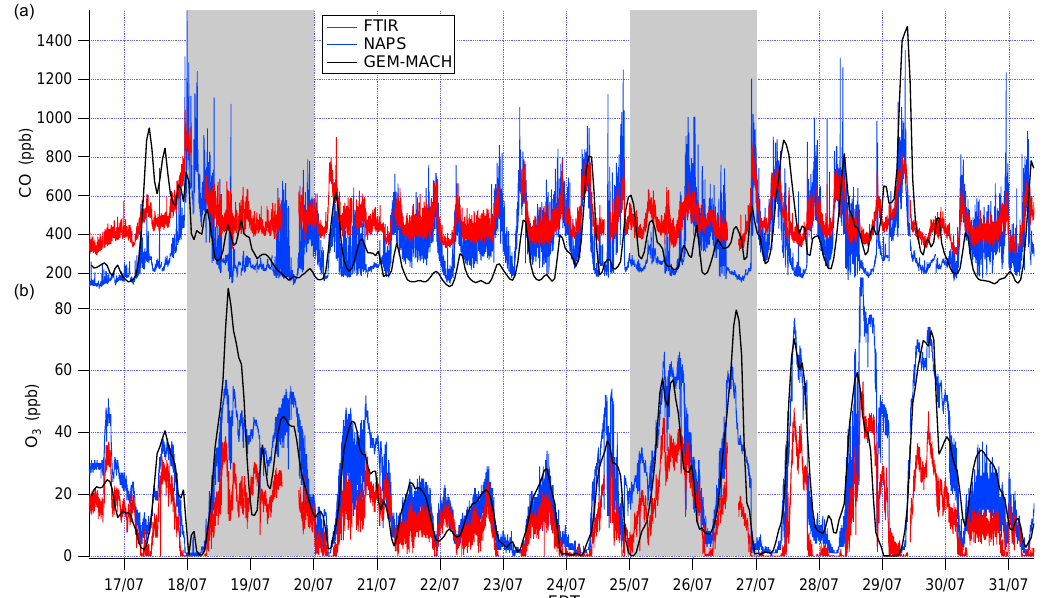
Figure 3. Time series of mixing ratios of CO (a) and O 3 (b) for the full study period. The red traces are mixing ratios retrieved from the FTIR spectra. The blue traces are measurements from the NAPS station. The black traces are output from GEM-MACH. Grey shaded areas highlight the weekend periods.